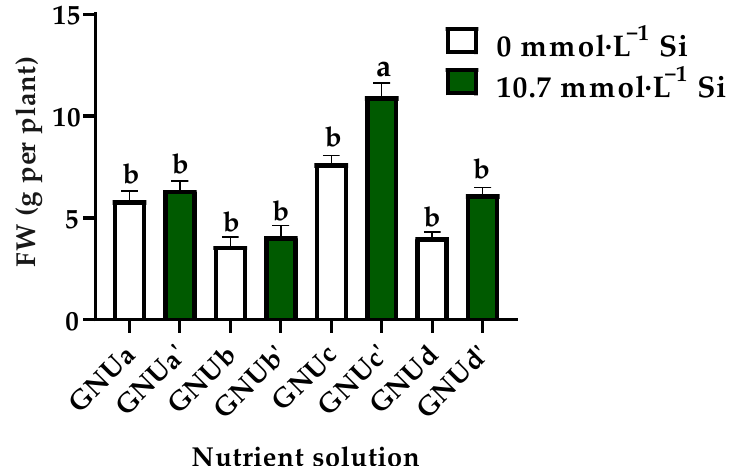
Figure 11. Fresh weight of Ssamchoo as affected by the nutrient solution 28 days after sowing in Experiment 3. Nutrient solutions had one of four levels of NO 3 − /NH 4+ /urea ratio (GNUa and GNUa‘,